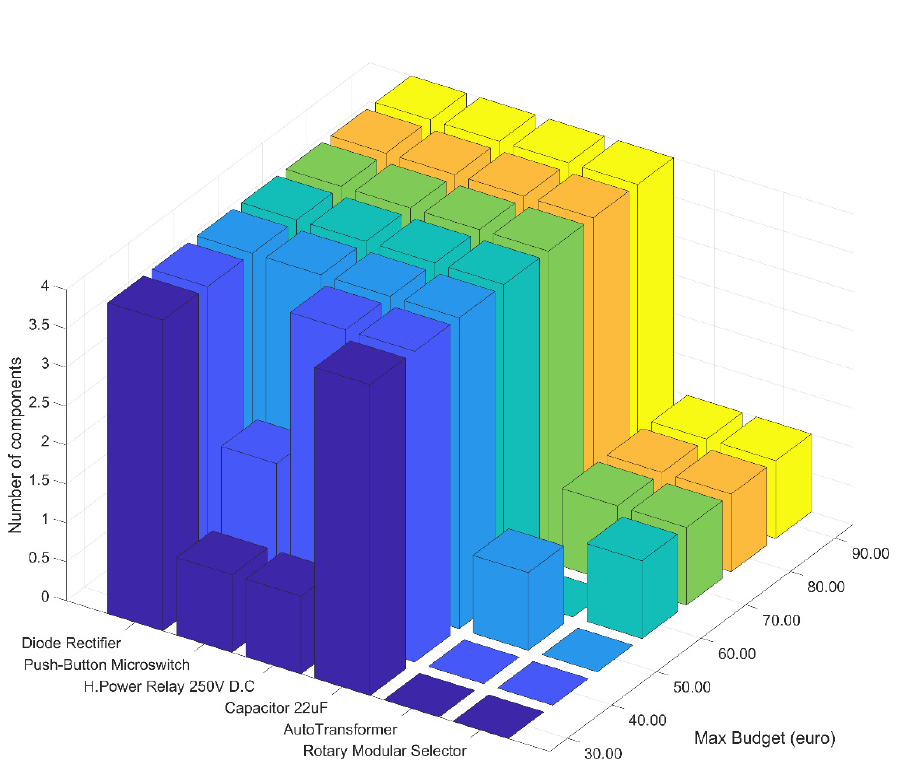
Figure 3. Graphical representation of PCB components considering different maximum client budgets for a dishwasher machine.